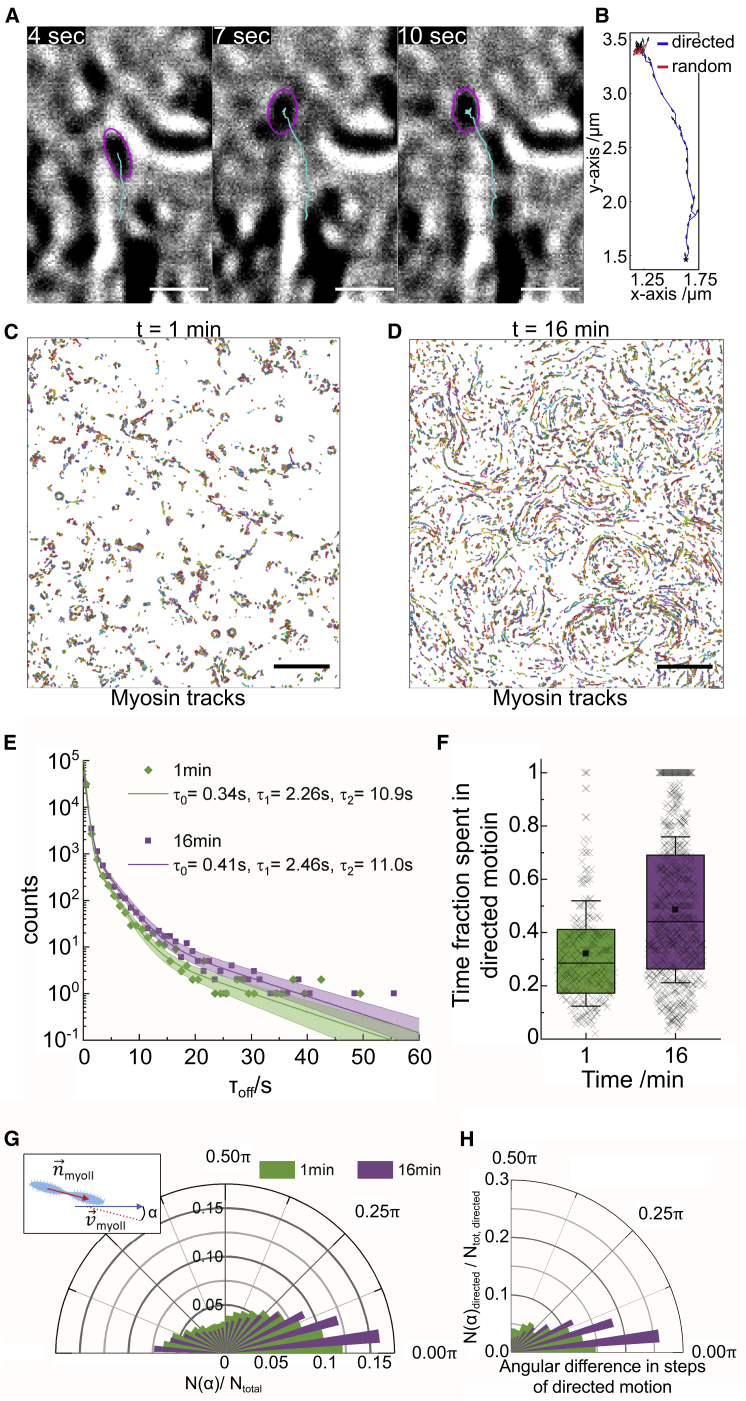
Single-particle tracking of myosin II filaments provides further insights into the change of myosin dynamics with decreasing ATP concentration. (A) Shown is an example image sequence showing the tracking of a myosin II filament (purple circle locates the current detection, cyan line depicts the particle’s traces). Scale bars, 1 μm. (B) Corresponding track with segmentation into segments of directed (blue) and random (red) motion. (C and D) Images depicting all tracked myosin II filaments (in alternating colors to distinguish individual tracks) at (C) t = 1 min (100 μM ATP) (N = 14,016) and (D) t = 16 min (N = 15,647). Scale bars, 5 μm. (E) Shown is a corresponding histogram of myosin II filament dwell times on actin (t = 1 min: green; t = 16 min: purple); best fits for the distributions were computed with the MEMLET fitting routine: triple exponential decay with tmin = 0.3 s (solid line); boundaries depict 95% confidence level. (F) Shown is a box plot depicting the ratio of time of directed motion versus dwell time for myosin II filaments displaying directed motion (N1 min = 221; N16 min = 640). (G) Shown is a radial histogram depicting the angular difference α between myosin II filament orientation and its velocity vector for all detected myosin II filament steps. (H) Shown is a radial histogram plot depicting the ratio of steps in directed motion versus all detected steps for each angular difference α, indicating that there is a clear increase of filaments that are aligned along their axis of propagation in the contractile state. To see this figure in color, go online.